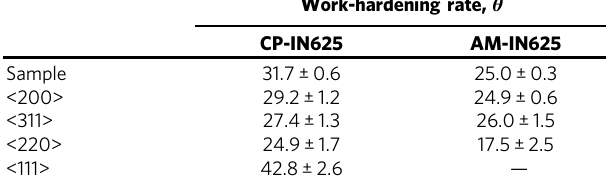
Table 1 Work-hardening rates, at 600 °C, determined experimentally for conventionally processed and additively